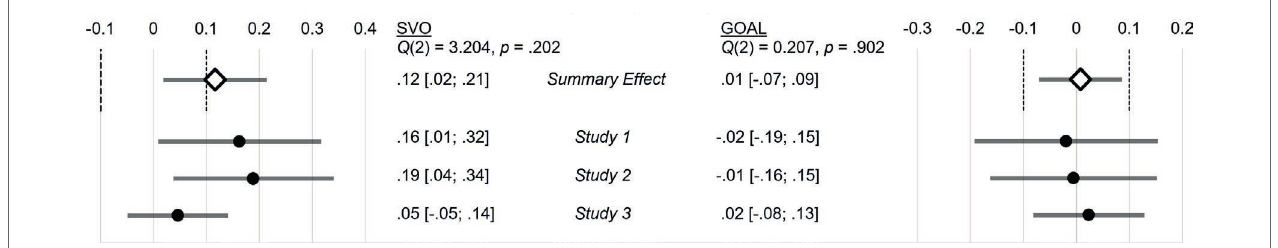
FIGURE 6 | Meta-analyses for SVO and Goal (vs. control 1) on prosocial behavior; point-estimates are partial correlation coefficients controlled for Goal and SVO, respectively; 95% CIs are based on bootstrapped SEs; summary effects (◊) are based on random-effects models; vertical dashed lines are equivalence bands of Δ r = ±0.10, which were defined after data collection; sample sizes: n S1 = 126, n S2 = 162, n S3 = 231; control condition 2 was omitted from the analysis. Q refers to heterogeneity across